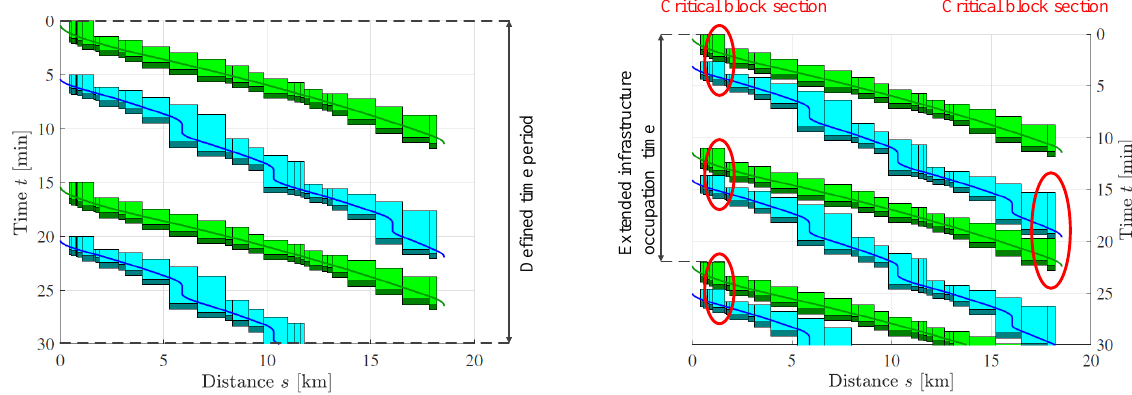
Figure 2: The left plot shows the timetable compression method with timetable before compres- sion. The right plot indicates the timetable compression method with timetable after compression including the minimum buffer time and the critical blocks. Note that the darker area below the blocks indicates the minimum buffer time between trains that are included in the extended block- ing